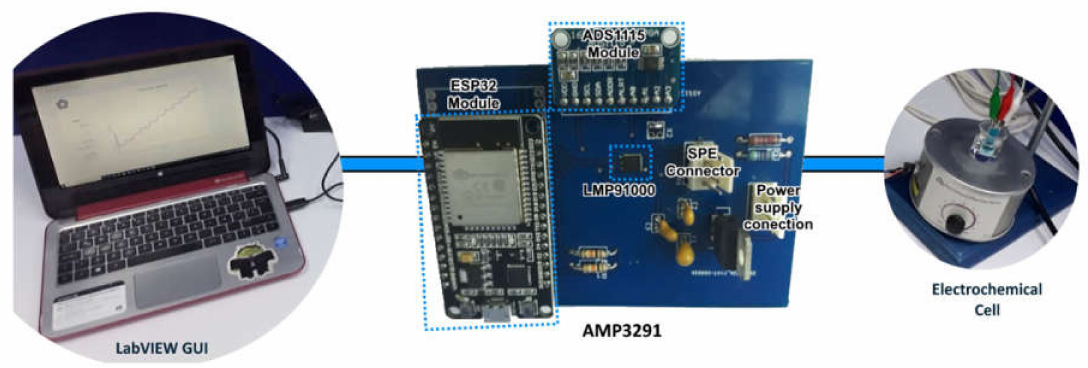
Figure 5. Setup of the sensing platform: AMP3291 reader and the SPE-AuNps.